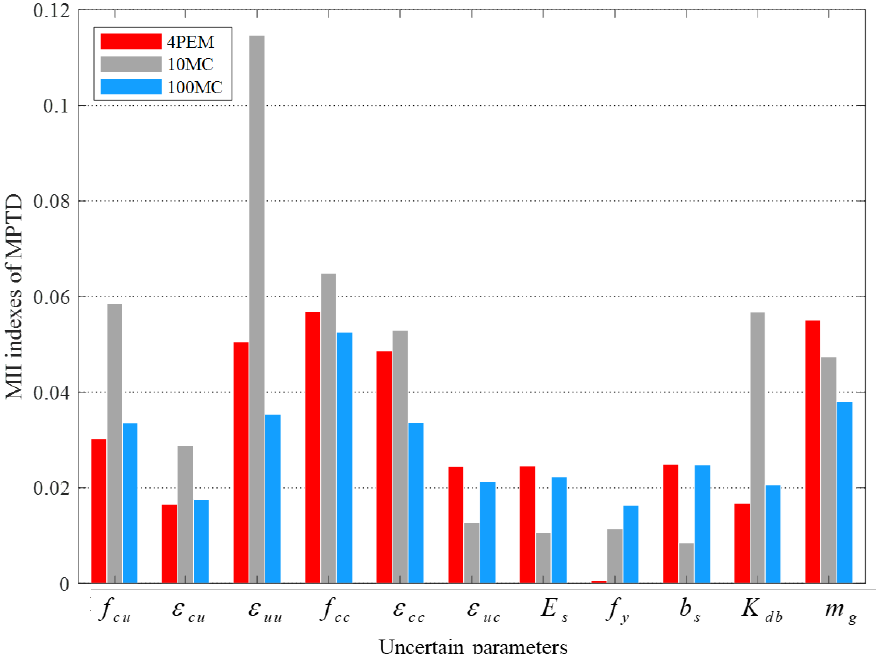
Figure 3. MII indexes of MPTD.